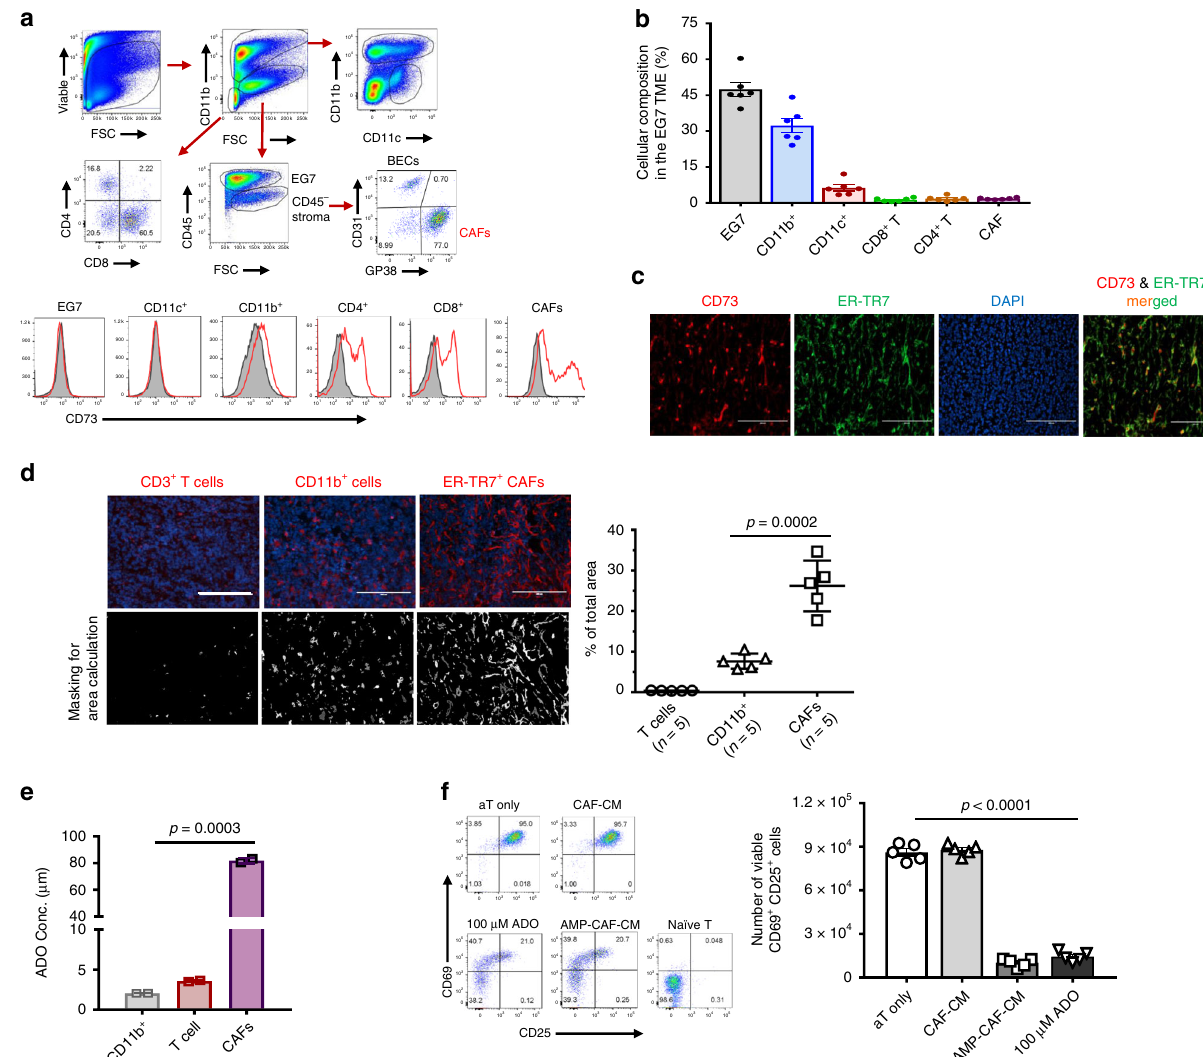
Fig. 2 CAFs in the murine TME are CD73 hi cells with a superior capacity for ADO generation than TILs. a EG7 tumors established s.c. in C57BL/6 WT mice for 15 days were used for assessment of cellular constituents of the EG7 TME via FACS as CD11b + myeloid cells, CD45 + CD11b − EG7-tumors (large) and lymphocytes (small cells), and CD45 − stroma. CD45 − cells were further de fi ned as GP38 + CD31 − CAFs and GP38 − CD31 + BECs. CD73 expression in each cellular subset in the TME was examined (red histogram) as compared with the isotype control for each population (gray). b Relative percentage of each cellular subset within the TME determined via FACS was summarized. n = 6. c IF staining was employed to examine CD73 + cell (red) bio-distribution in correlation with ER-TR7 + (green) fi broblastic stroma and DAPI nuclear counterstain (blue). Co-localization of CD73 high and ER-TR7 + cells was illustrated via merging the images. d The relative area occupied by CD3 + T, CD11b + myeloid cells, and ER-TR7 + CAFs (red) in the EG7 TME was determined via a computer-assisted software following masking it to white/gray signals and calculated as the percentage of total area. e CD11b + , CD3 + cells, and CAFs were puri fi ed from the EG7 TME via FACSort. Their capacity for ADO generation within 2 h in the presence of 200 μ M AMP was compared. f Puri fi ed CD8 T cells were activated by α -CD3/ α -CD28 beads in CAF-conditioned medium (CAF-CM), pre-incubated with or without 200 μ M AMP. Changes in the cell surface expression of CD69 and CD25 were examined and compared with the 100 μ M ADO control via FACS 15 h post- activation. The viable CD69 + CD25 + CD8 + T cells were calculated and summarized to the right. Error bars depict mean ± SEM. p values were determined via two-tail unpaired Student ’ s t -test. All experiments were repeated at least two times. Source data are provided in the Source Data fi